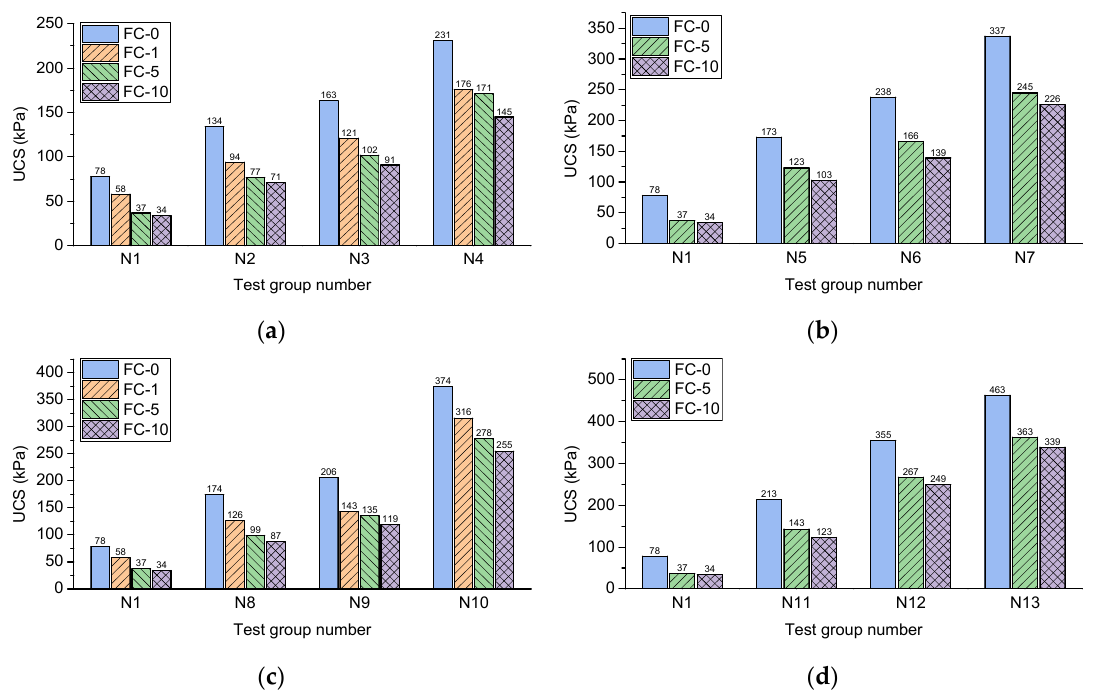
Figure 6. Effects of basalt fiber and lime on UCS under different freeze–thaw cycles: ( a ) L = 6 mm and LC = 1%; ( b ) L = 6 mm and LC = of 3%; ( c ) L = 12 mm and LC = 1%; and ( d ) L = 12 mm and LC = 3%.